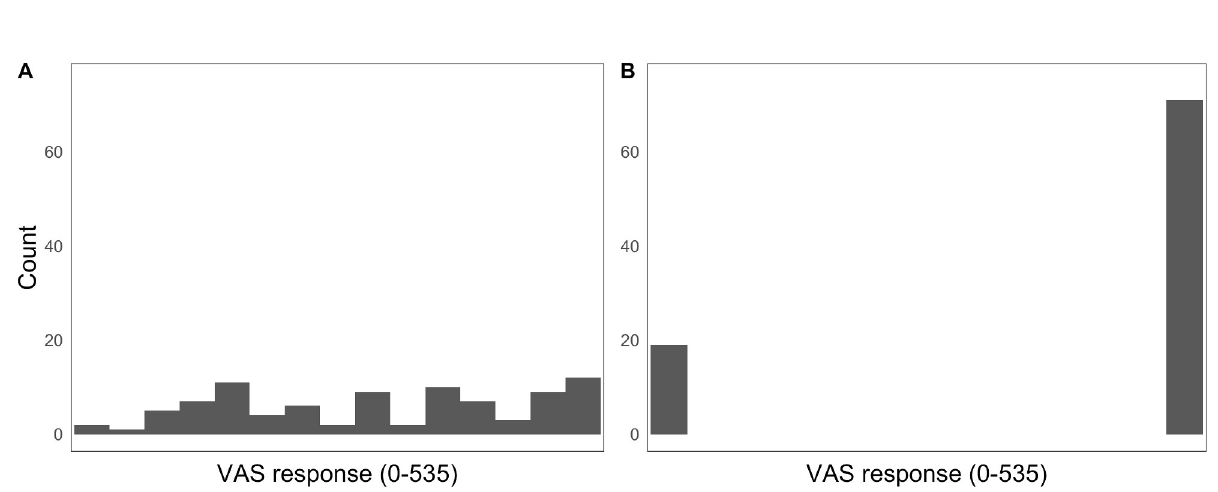
Fig 2. Distribution of VAS responses for a representative gradient (A) and categorical (B) listener. VAS = visual analogue scale.